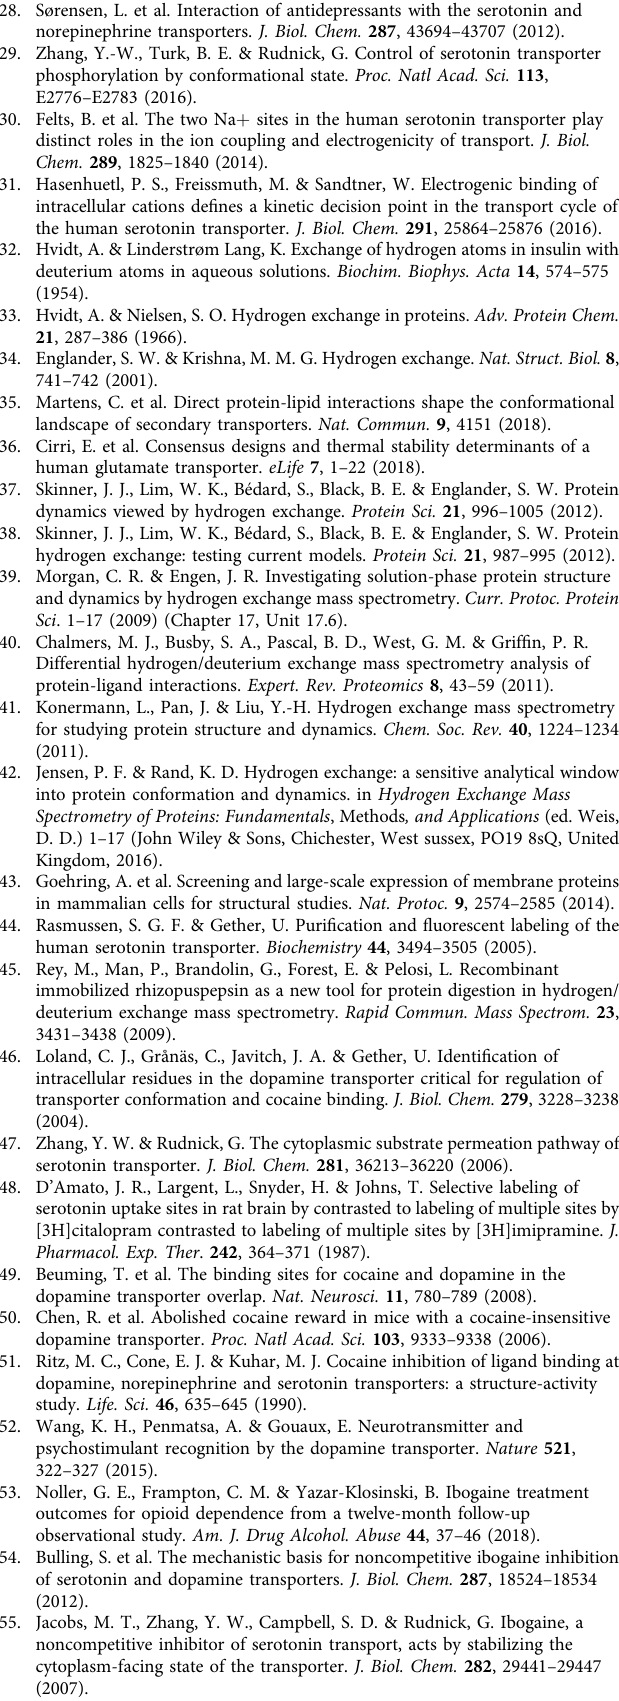
data fi les including processed DynamX fi les and an overview of the HDX-MS data (Supporting Tables 1 – 4) have been uploaded to the PRoteomics IDEnt fi cation (PRIDE)